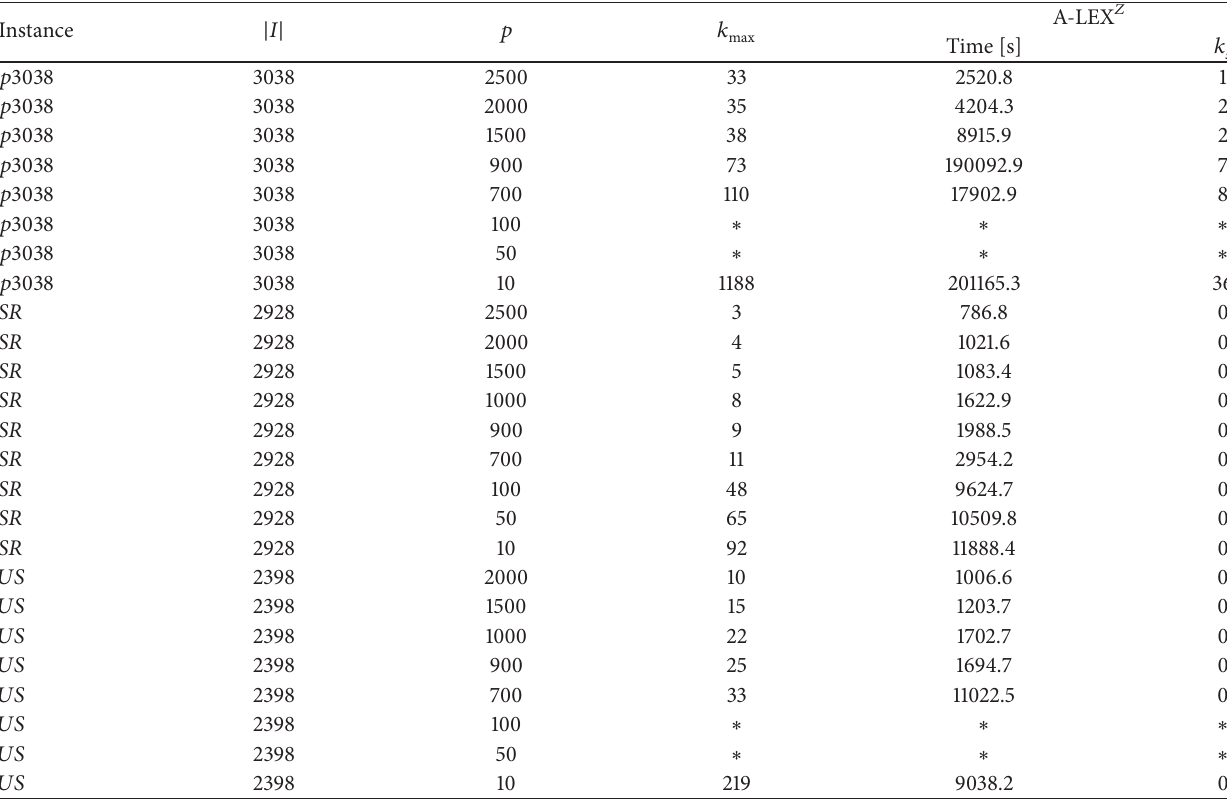
Table cells filled with the symbol “ ∗ ” indicate the instances when the algorithm did not terminate within 3